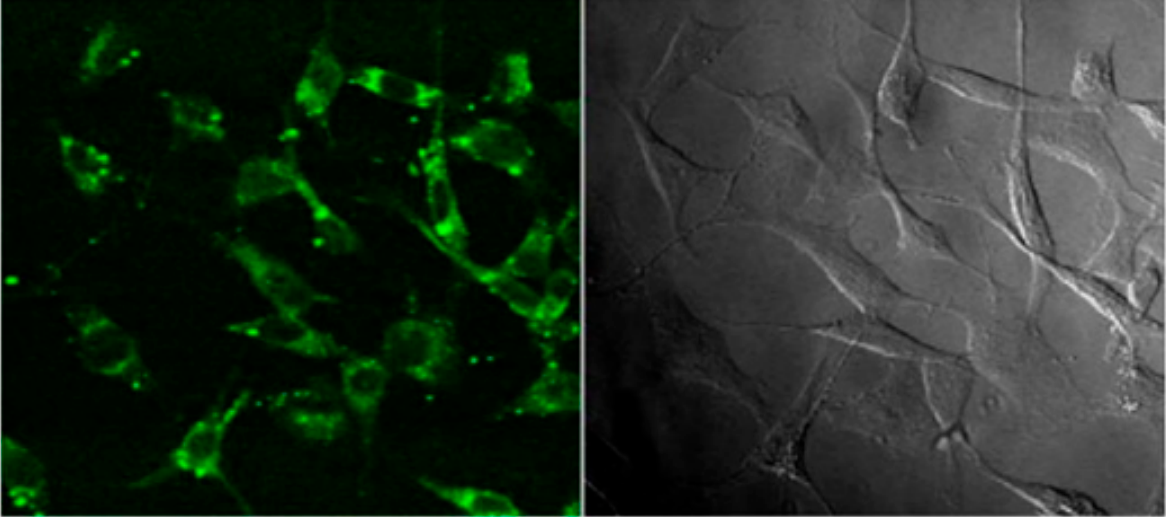
Figure 6. Confocal microscopy images of 3T6 cells post incubation with fluorescent CNT (image reproduced with permission from reference) [41].